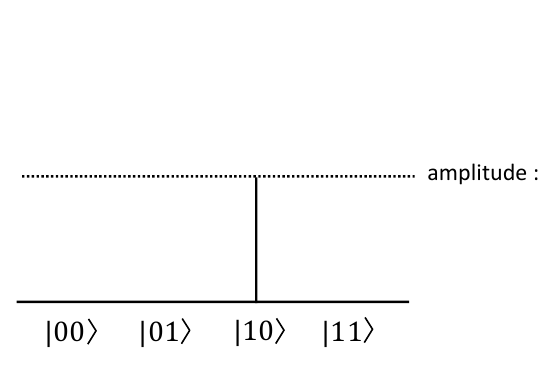
Figure 10. Condition after diffusion of the Grover